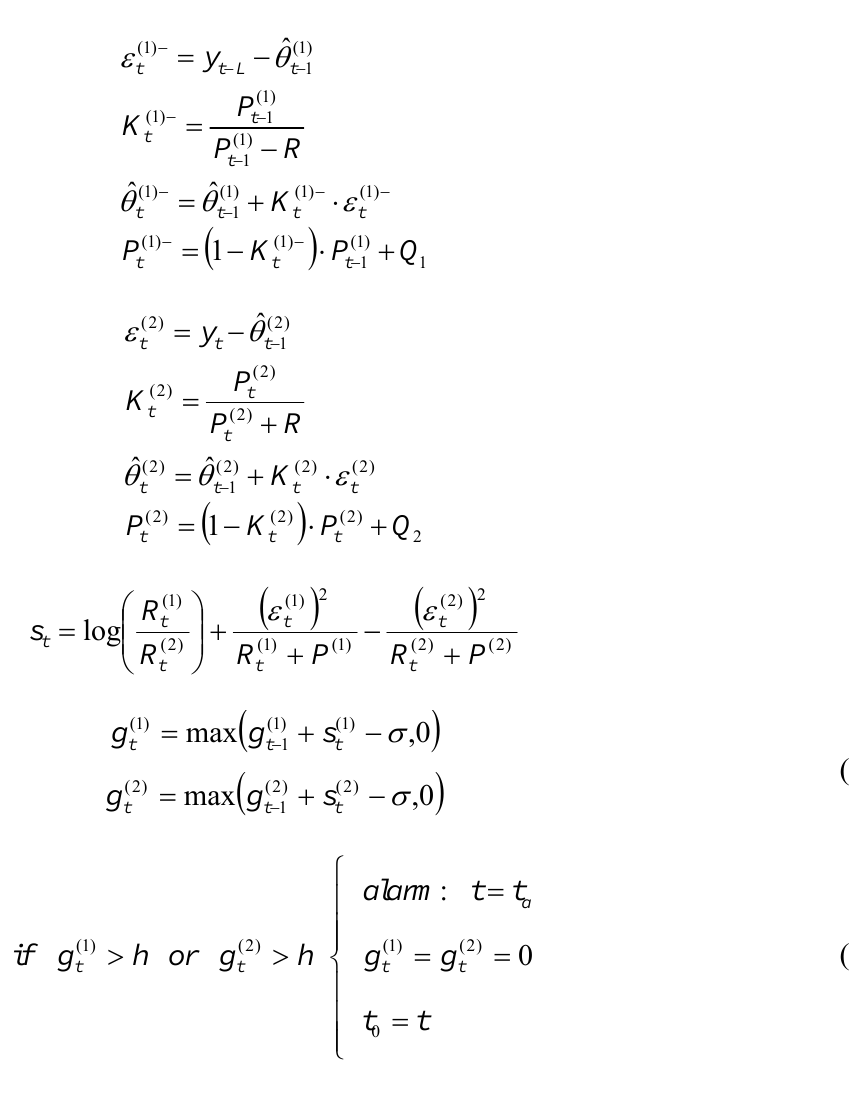
Figure 2. Scheme for sliding